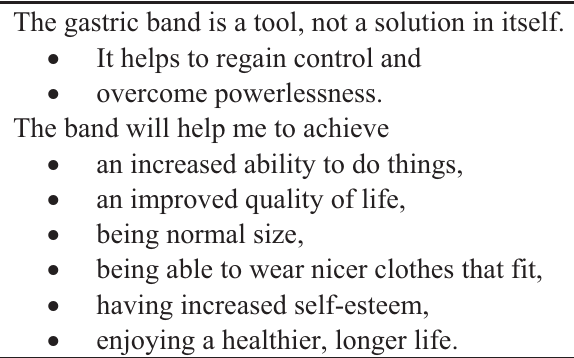
Table 4. Patient expectations towards LAGB